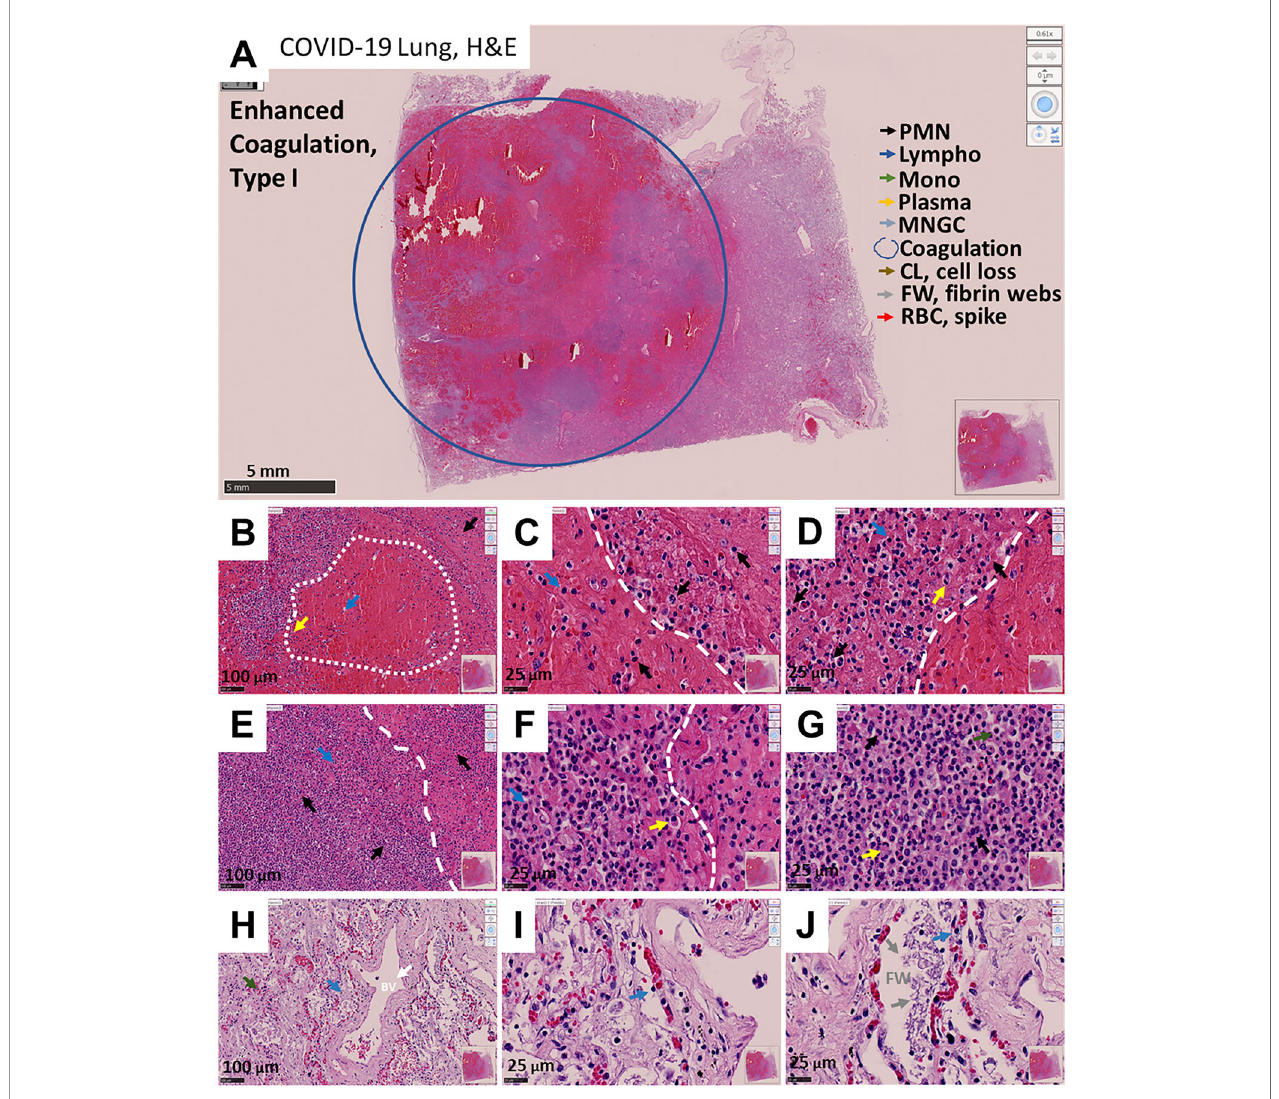
FIGURE 1 | Representative microphotograph of eight serial sections of lung obtained from a deadly case of COVID-19 with hemorrhagic events and immune in fi ltration. (A) Representative H&E-stained images of lung classi fi ed as enhanced coagulation or type I damage. Low magni fi cation allows us to appreciate the degree of damage and the large hemorrhagic events. The blue circle indicates the area with signi fi cant hemorrhagic and hemolysis events. Bar: 5 mm. (B – D) Correspond to higher magni fi cation to denote the interphase between blood and the immune rim around the lesions (see dotted line). Bar 100 µm and 25 µm. (E – G) Correspond to the immune in fi ltration around the lesions. Bar 100 µm and 25 µm. (H – J) Represent areas outside of the hemorrhagic areas but with intravascular retention of red blood cells. Observe the fi brosis and formation of intravascular fi brin webs. Due to these characteristics, we named this phenotype enhanced coagulation. As indicated in (A, B – J) arrows of different colors indicated different cell types, coagulation areas, cell loss (CL), Fibrin webs (FW), and red blood cells with spiked membrane. n = 4 different individuals with 15-20 serial